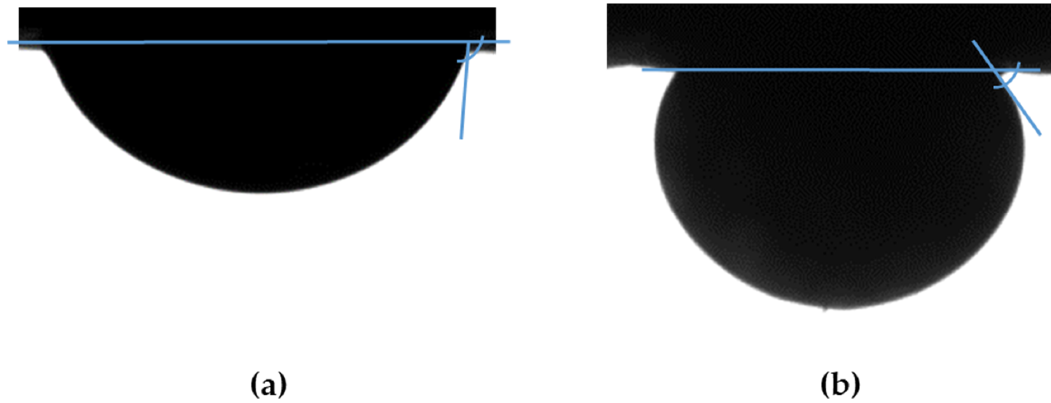
Figure 5. Images illustrating contact angle measurements. ( a ) Measurement on an aged rock with no CO 2 . ( b ) Measurement on aged coquina using CO 2 -saturated fluids. Images captured after 24 h of experiment.